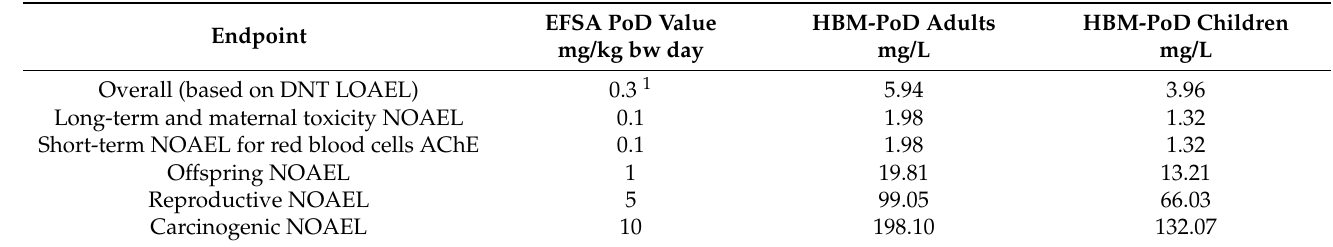
Table 1. Proposed human biomonitoring points of departure (HBM-PoD) for chlorpyrifos following the EFSA [6] hazard